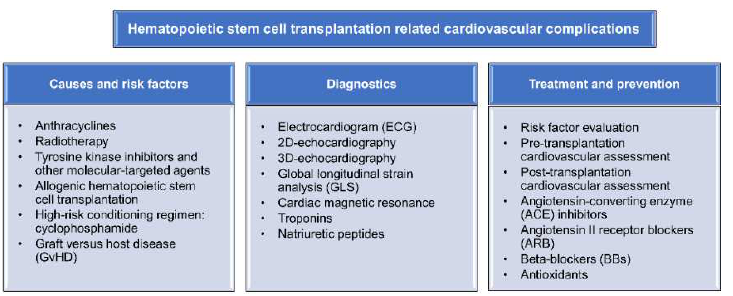
Figure 1. Schematic overview of hematopoietic stem cell transplantation-related cardiovascular complications.